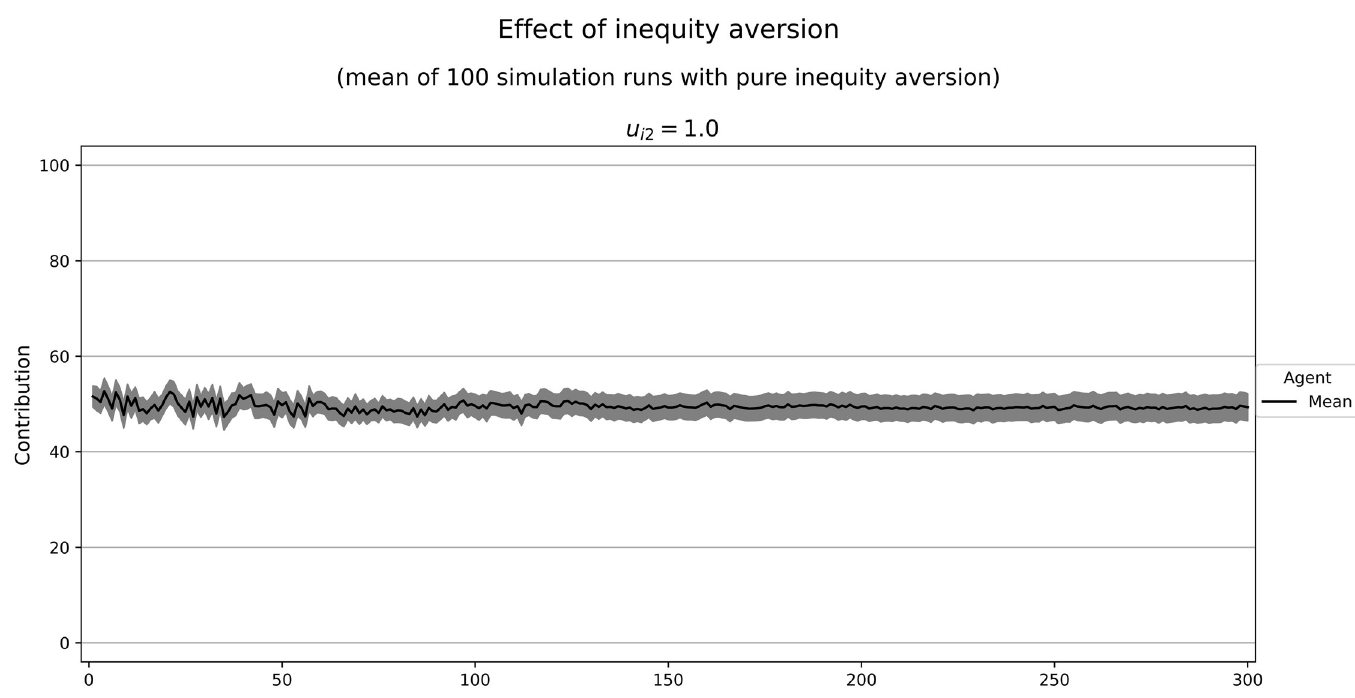
Fig 8. Contributions of purely inequity-averse agents. Selfishness: 0, inequity aversion: 1 competitiveness: 0, social welfare: 0, altruism: 0. Marginal utility of the own contribution: 0. In gray: confidence interval (95%) around the mean.